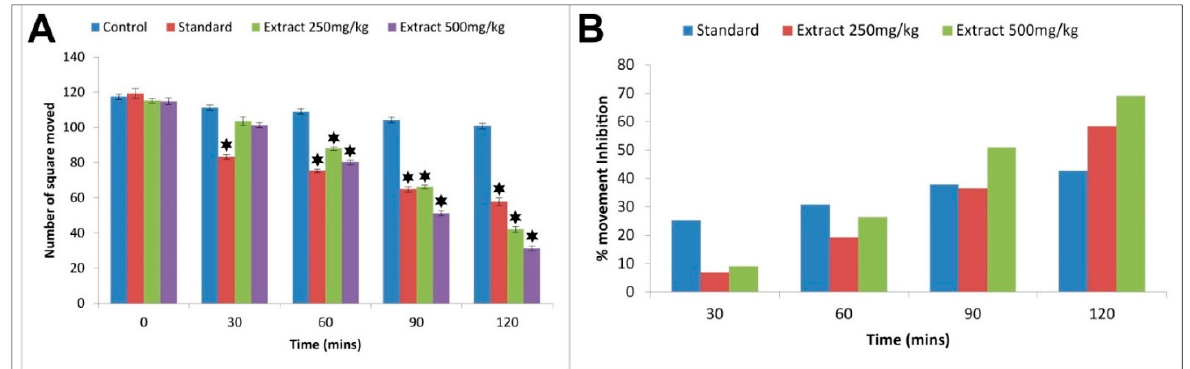
Figure 2. Neuropharmacological activity of G. terandra in open field test. ( A ) Number of squares moved by mice vs. time, ( B ) percent movement inhibition of mice with time. Here, values are presented as mean ± SD ( n = 5). * indicates statistical significance when p < 0.05.